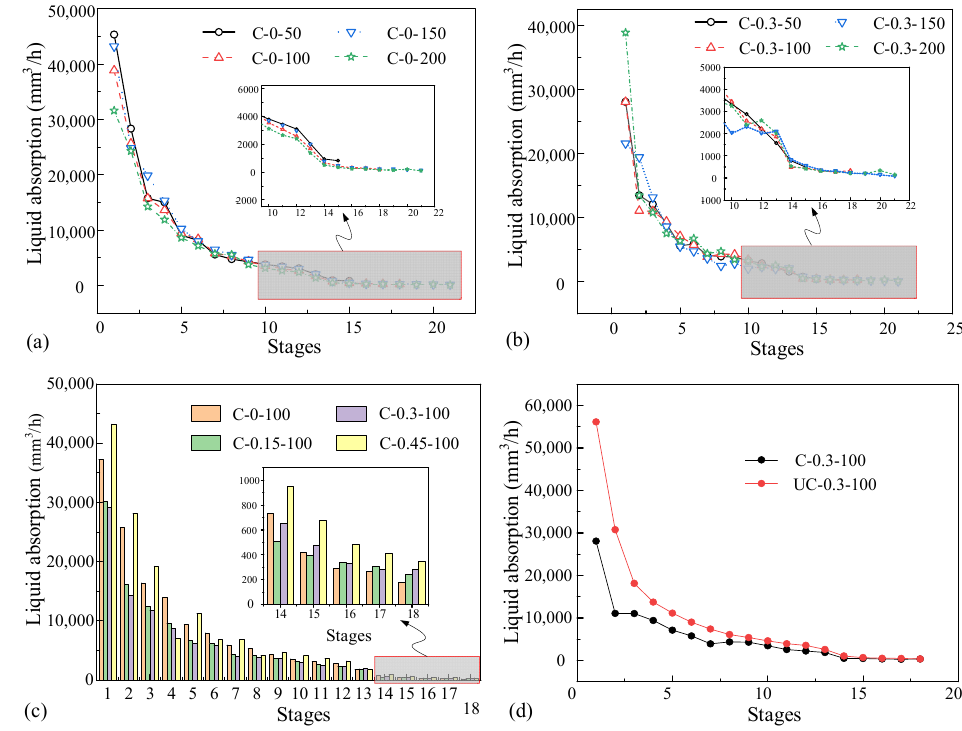
Figure 4. Liquid absorption of unsaturated concrete under different loading scenarios: ( a ) corrosion only; ( b ) different loading cycles; ( c ) different stress levels; and ( d ) coupling and uncoupling.